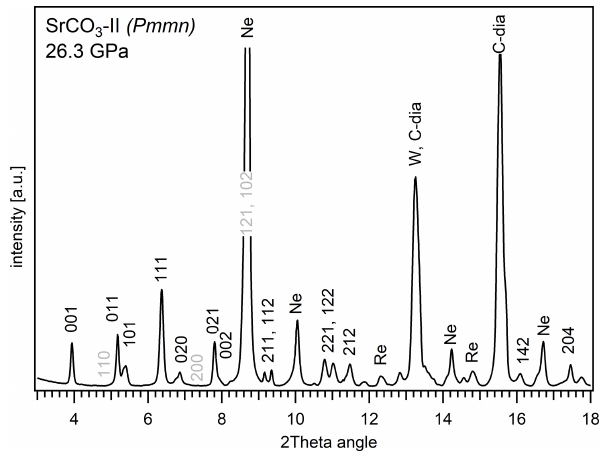
Figure 3. A representative XRD pattern of post-aragonite SrCO 3 -II obtained from single-crystal data at 26.3GPa derived from continu- ous rotation around one axis from − 27 to + 27 ◦ (wide scan image). Reflections corresponding to SrCO 3 -II that are absent, less intense, or overlaid are marked in